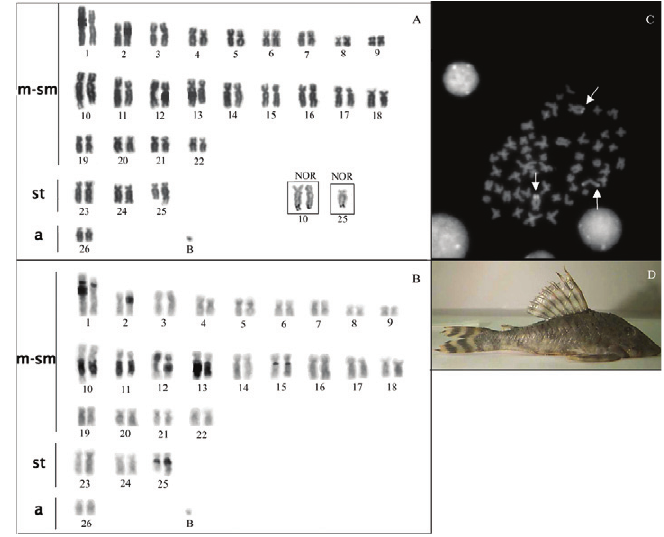
Fig. 2. Karyotype of a Peckoltia sp. 1, sequentially Giemsa-stained (A) and C-banded (B) chromosomes. The CMA -stained metaphase of the same specimen (C) revealed CMA 3 NOR-bearing chromosome pair. The specimen was obtained from Jari river